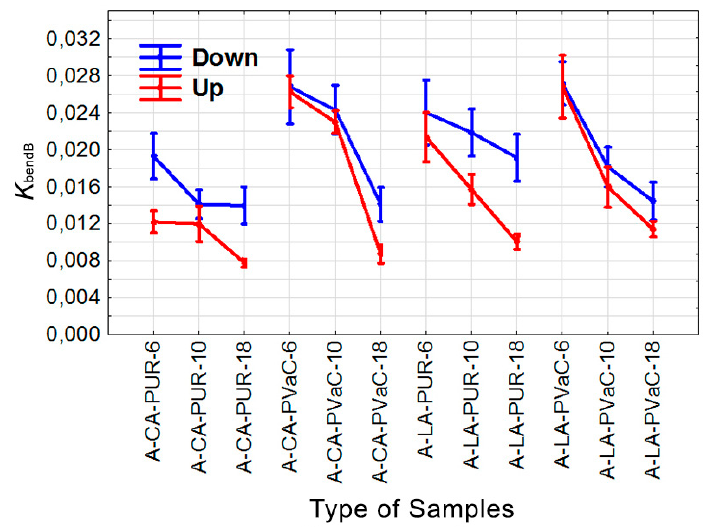
Figure 6. K bendB in case of aspen.